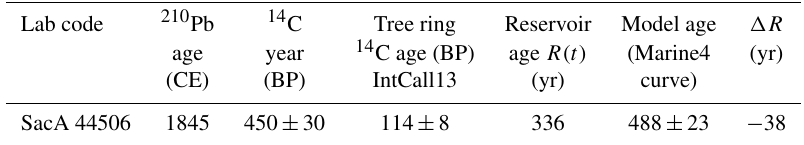
Table 3. 14 C age of recent pre-bomb mollusk samples in GEM4 core. The reservoir age R(t) and (cid:49)R were calculated using the 210 Pb ex